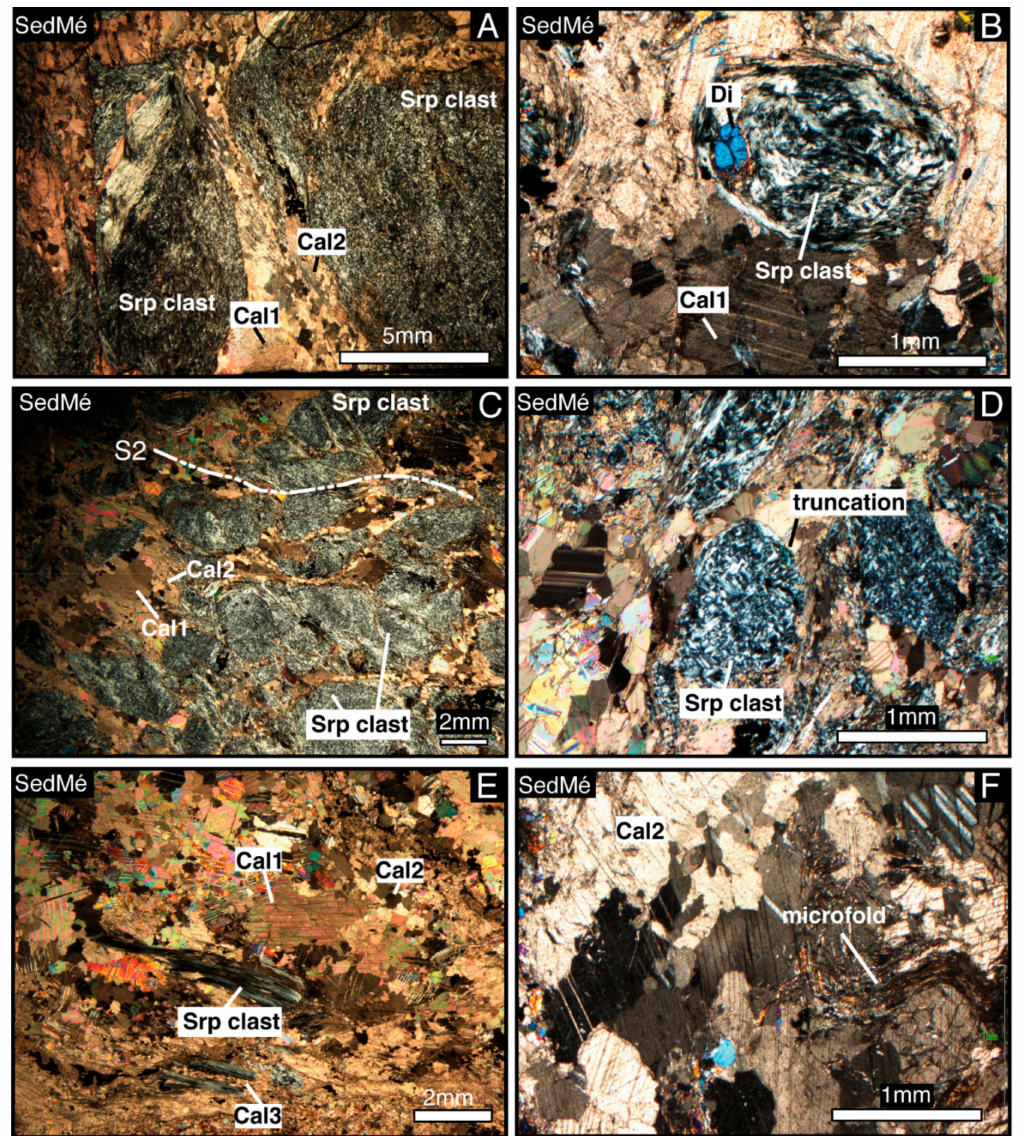
Figure 10. Photomicrographs illustrating the main microstructural features of SedM é . All pictures are taken in crossed-polarized light. Mineral abbreviations after [104]. ( A ) Millimeter- to centimeter-sized ultramafic (serpentinite) clasts embedded in a Cb-rich matrix. Clasts have sub-rounded to elongated shapes. Their boundaries are either truncated or transposed near the contact with the Cb-rich matrix. Clasts on the left show an internal foliation marked by the shape preferred orientation (SPO) of Srp. Foliation is crenulated without the development of a di ff erentiated cleavage. Calcite porphyroblasts (Cal1) and neoblasts (Cal2) are visible in the carbonate-rich matrix. ( B ) Serpentinite clast with Di grain (see text). The clast internal foliation is folded and truncated along the clast margins without drag into the matrix foliation (probably enhanced by dissolution / precipitation). ( C ) Foliated type of SedM é . Foliation (S 2 ) is defined by SPO of ultramafic clasts or clast aggregates and by carbonate (Cal2) ribbons. Microboudinage of clasts is also recognizable. ( D ) Ultramafic clasts preserving internal relict (or recrystallized) mesh-texture of serpentine. Clasts show either transposed or truncated edges. Truncation is probably enhanced by dissolution / precipitation. ( E ) Matrix-supported type of SedM é characterized by mm- to cm-sized ultramafic clasts di ff usively transposed within the matrix consisting of isotropic or weakly foliated fabric. ( F ) Relic of S 1 foliation marked by microfolded layers composed of Cal1 and Amp1 in isotropic types of SedM é